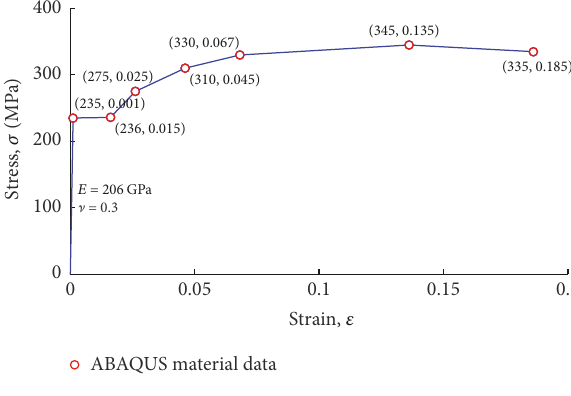
Figure 7: Plastic strain distribution of beam flange.